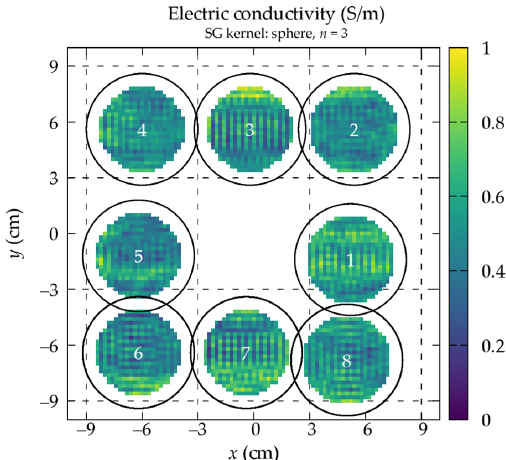
Figure 6. Electric conductivity maps estimated with the phase-based Helmholtz-EPT from the acquisitions under reproducibility conditions. The reported results are obtained with a spherical Savitzky–Golay kernel with n = 3 .